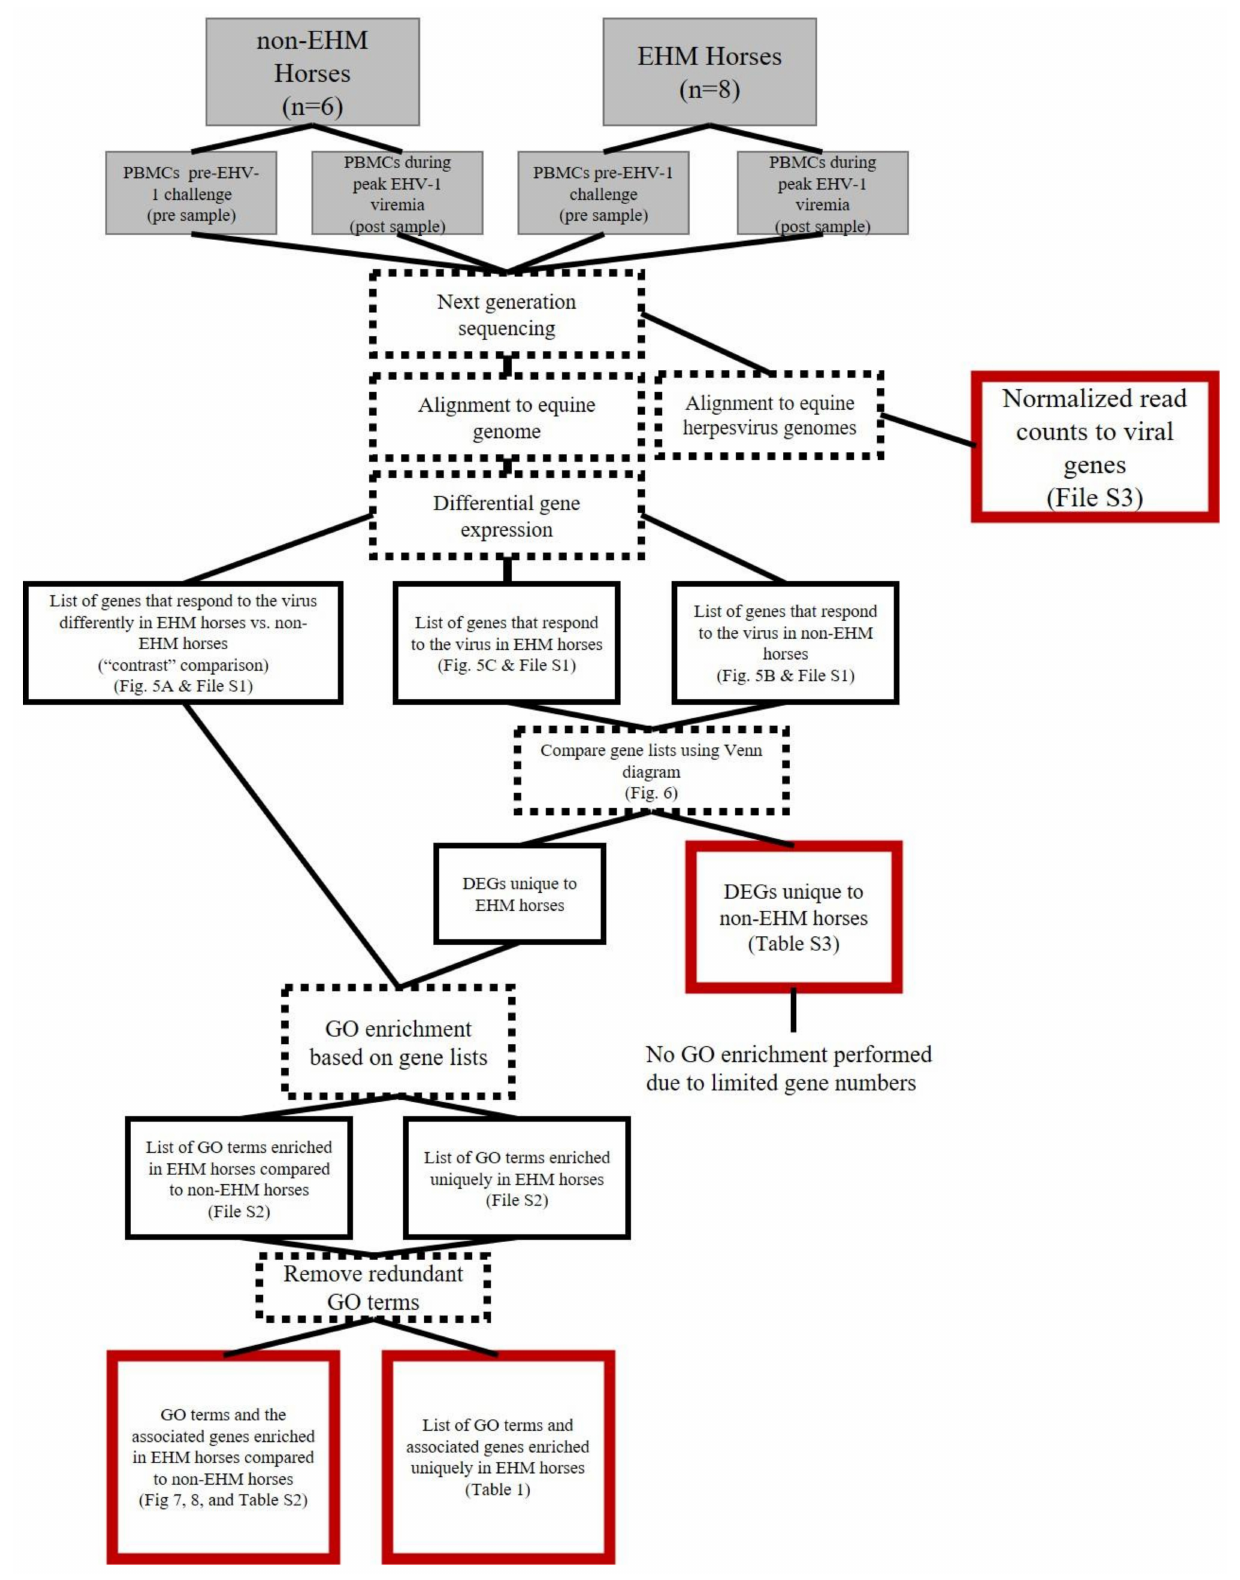
Figure 1. Summary of mRNA sequencing data analysis. RNA was extracted from PBMCs from horses prior to and during EHV-1 CH. The gray boxes represent experimental design. The dashed outline boxes are data analysis processes (actions). Black and red boxes represent output. The red outline indicates final output used for